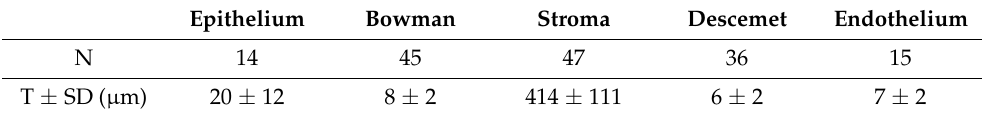
Table 1. Data of corneal layers. Number of samples of each layer (N), mean thickness (T), and standard deviation